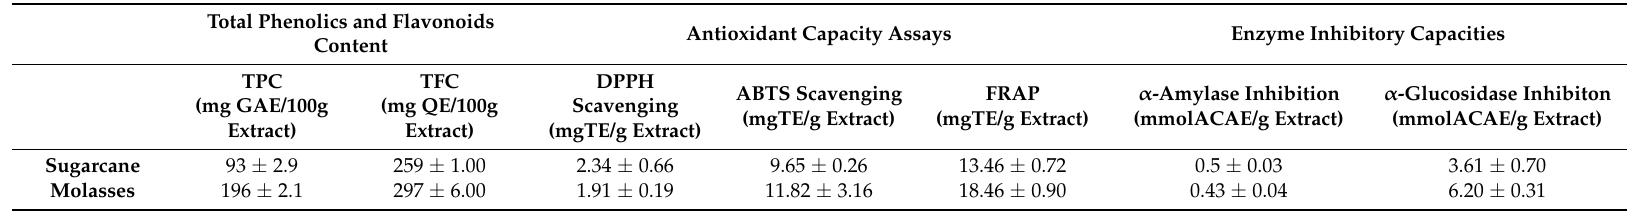
Table 4. Total phenolics and flavonoids content, antioxidant capacity assays and α -amylase and α -glucosidase inhibitory capacities of sugarcane juice and